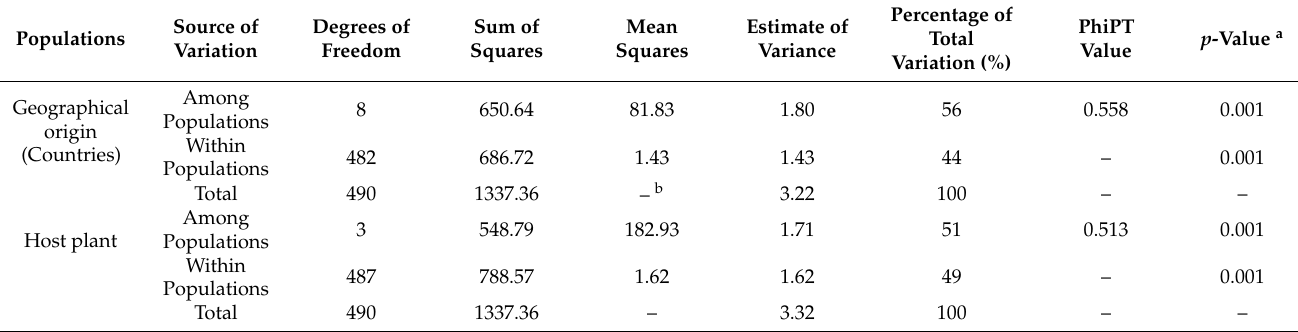
Table 2. Analysis of molecular variance (AMOVA) of isolates from the Ceratocystis manginecans complex from nine geographical populations and four host plant